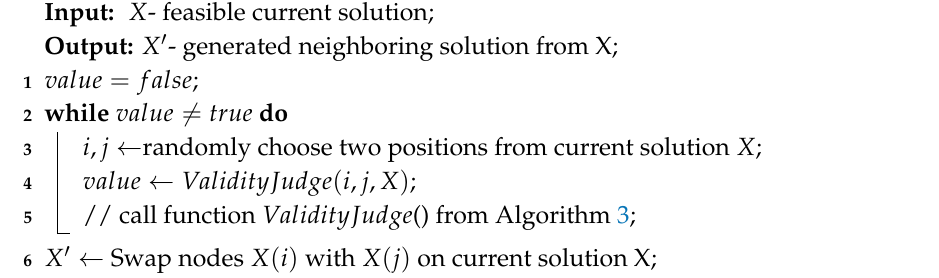
Algorithm 4: Swap-and-Judge Strategy for